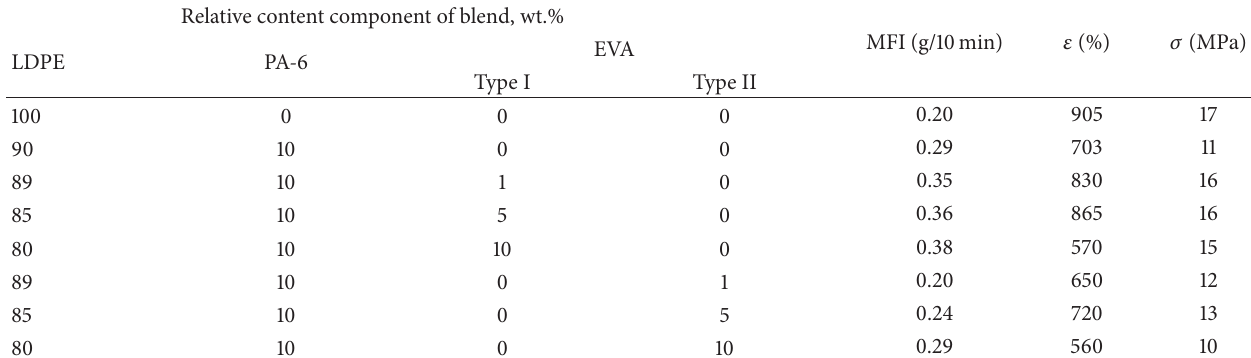
Table 1: Influence of type of EVA on properties of polymer composite based on LDPE and PA-6 in presence of a mixture of stabilizers of 0.1wt.% of Agidol 40 and 0.1 wt.% Irgafos 168.